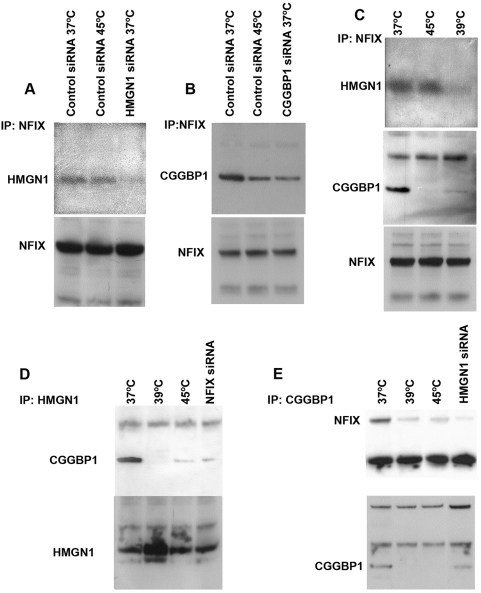
Interactions between endogenously expressed NFIX, CGGBP1 and HMGN1 in U-2987 MG cells.HMGN1 is immunoprecipitated with NFIX at 37°C, after 45°C-5 min heat shock and is specifically eliminated by HMGN1-siRNA (A). CGGBP1 is immunoprecipitated with NFIX at 37°C and is reduced by 45°C-10 min heat shock or CGGBP1-siRNA (B). HMGN1-NFIX interactions survive 45°C-10 min heat shock but not 39°C-48 h heat shock, whereas CGGBP1-NFIX interactions are sensitive to both acute and chronic heat shocks (C). HMGN1 and CGGBP1 interact at 37°C which is severely reduced by 39°C-48 h or 45°C-10 min heat shock and NFIX-siRNA (D). NFIX precipitated by CGGBP1 at 37°C is severely reduced by 39°C-48 h or 45°C-10 min heat shock and HMGN1-siRNA (E). NFIX levels were not affected by heat shock (A, B and C), HMGN1 levels were increased by 39°C-48 h heat shock (D), and CGGBP1 levels were decreased by heat shock (E).